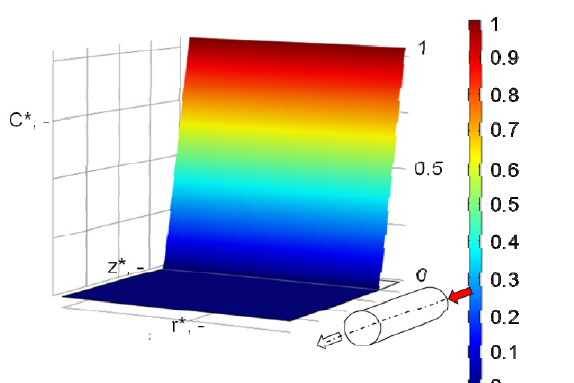
= 129, R / δ = 0.38, rad ,max i C